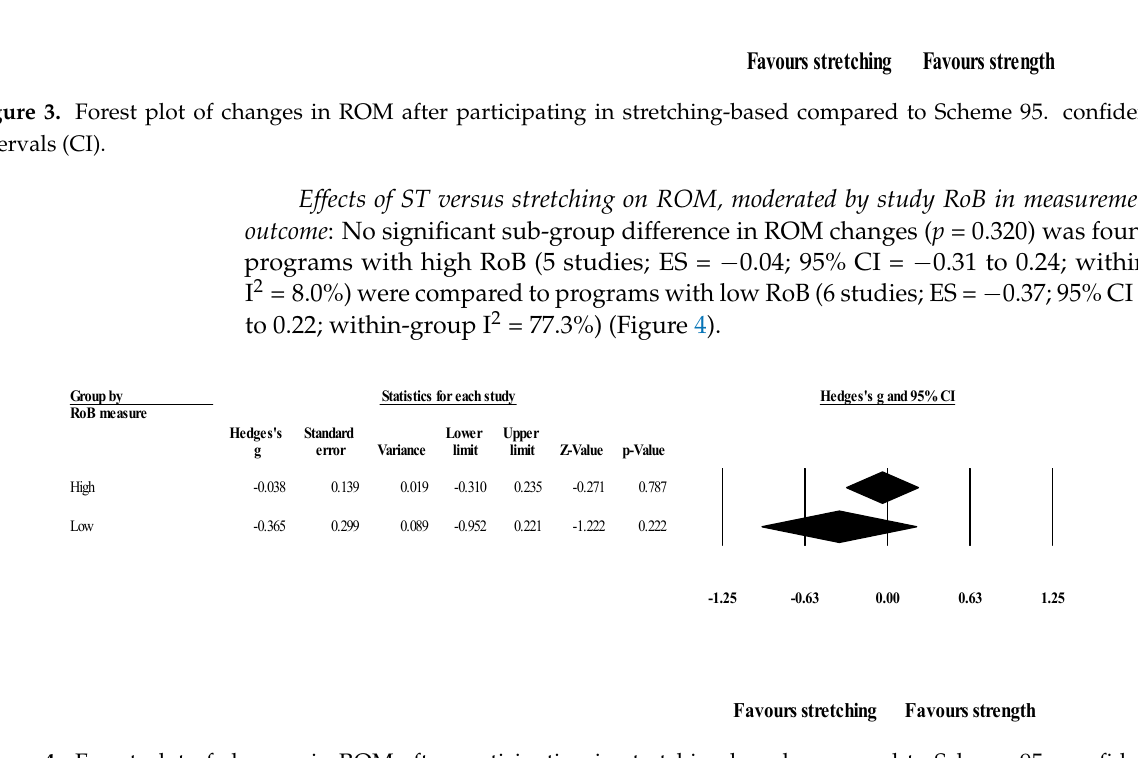
Figure 4. Forest plot of changes in ROM after participating in stretching-based compared to Scheme 95. confidence intervals (CI).